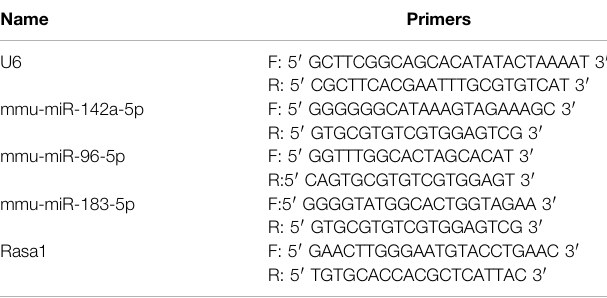
TABLE 2 | Reverse-transcription polymerase chain reaction primers.